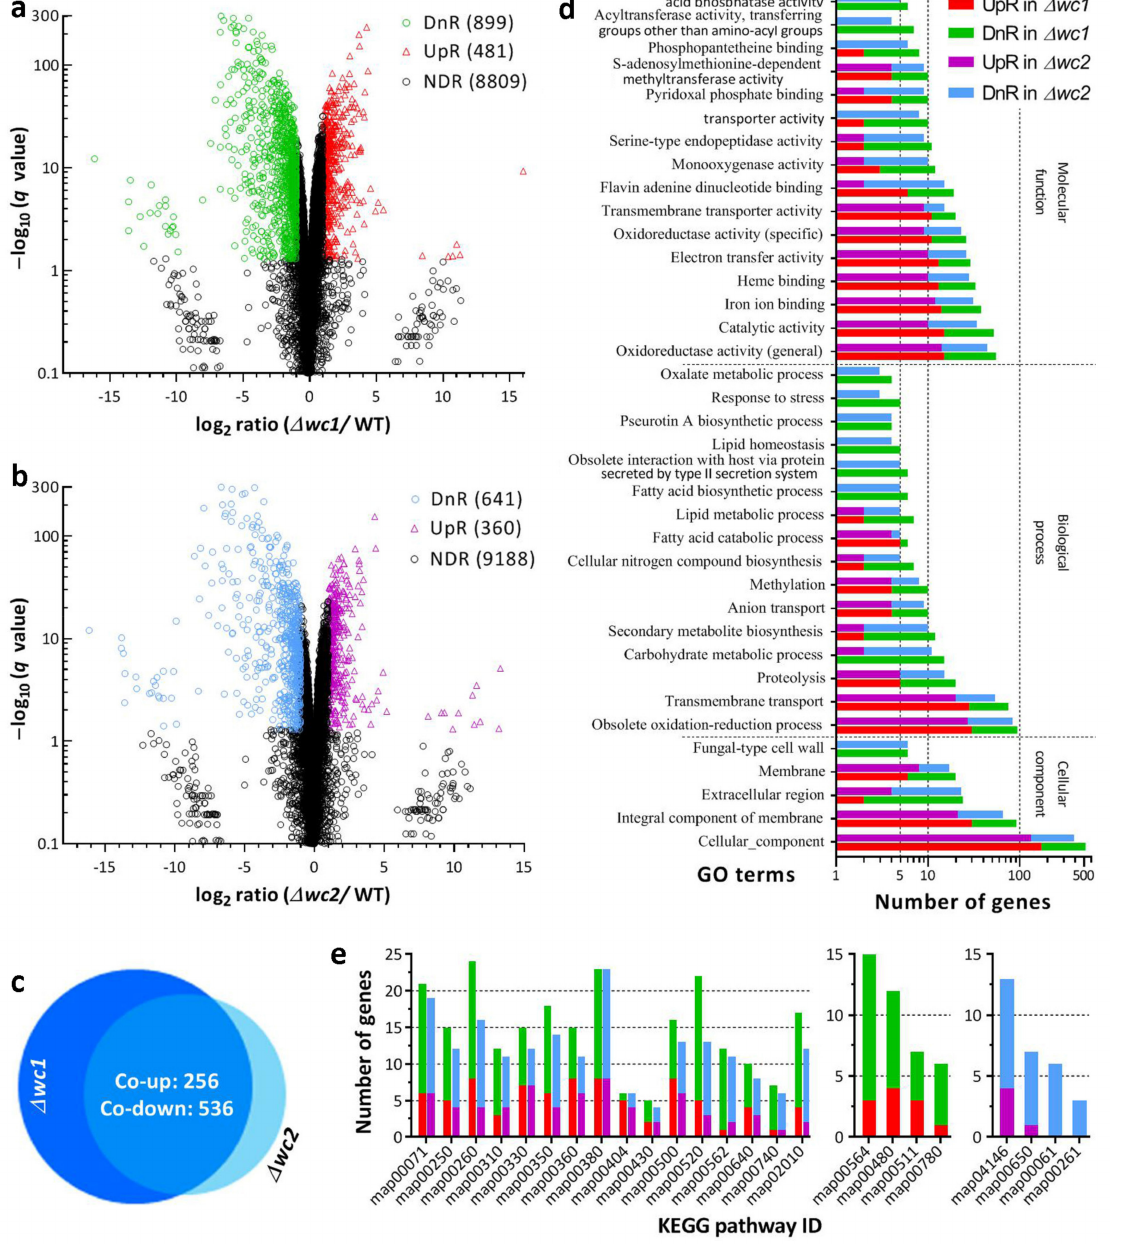
Figure 3. Overlapping roles of WC1 and WC2 in regulating gene expression networks of B. bassiana . ( a , b ) Distributions of log 2 ratio values and q values for all genes in the transcriptomes constructed with three 3-day-old SDAY cultures (replicates) of the ∆ wc1 , ∆ wc2 , and WT strains grown at the optimal regime of 25 ◦ C and L:D 12:12. DnR and UpR denote downregulated (log 2 ratio ≤ − 1) and upregulated (log 2 ratio ≥ 1) genes at the significant level of q < 0.05, respectively. NDR, not differentially regulated at significant levels. ( c ) Counts of genes significantly co-upregulated and co-downregulated in ∆ wc1 and ∆ wc2 . ( d ) Counts of differentially expressed genes (DEGs) enriched ( p < 0.05) to main GO terms co-downregulated in ∆ wc1 and ∆ wc2 . ( e ) Counts of DEGs enriched ( p < 0.05) to KEGG pathways co-downregulated in both ∆ wc1 and ∆ wc2 (left), and downregulated in ∆ wc1 (middle) or ∆ wc2 (right)